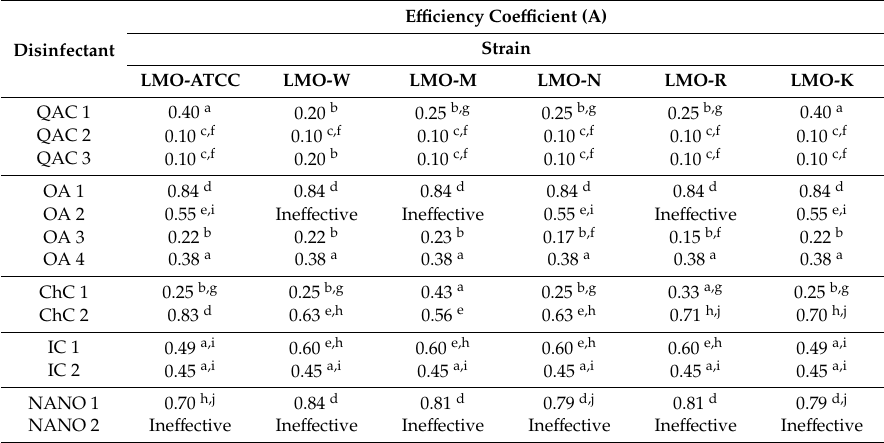
Table 5. E ffi ciency coe ffi cient values for tested strains and